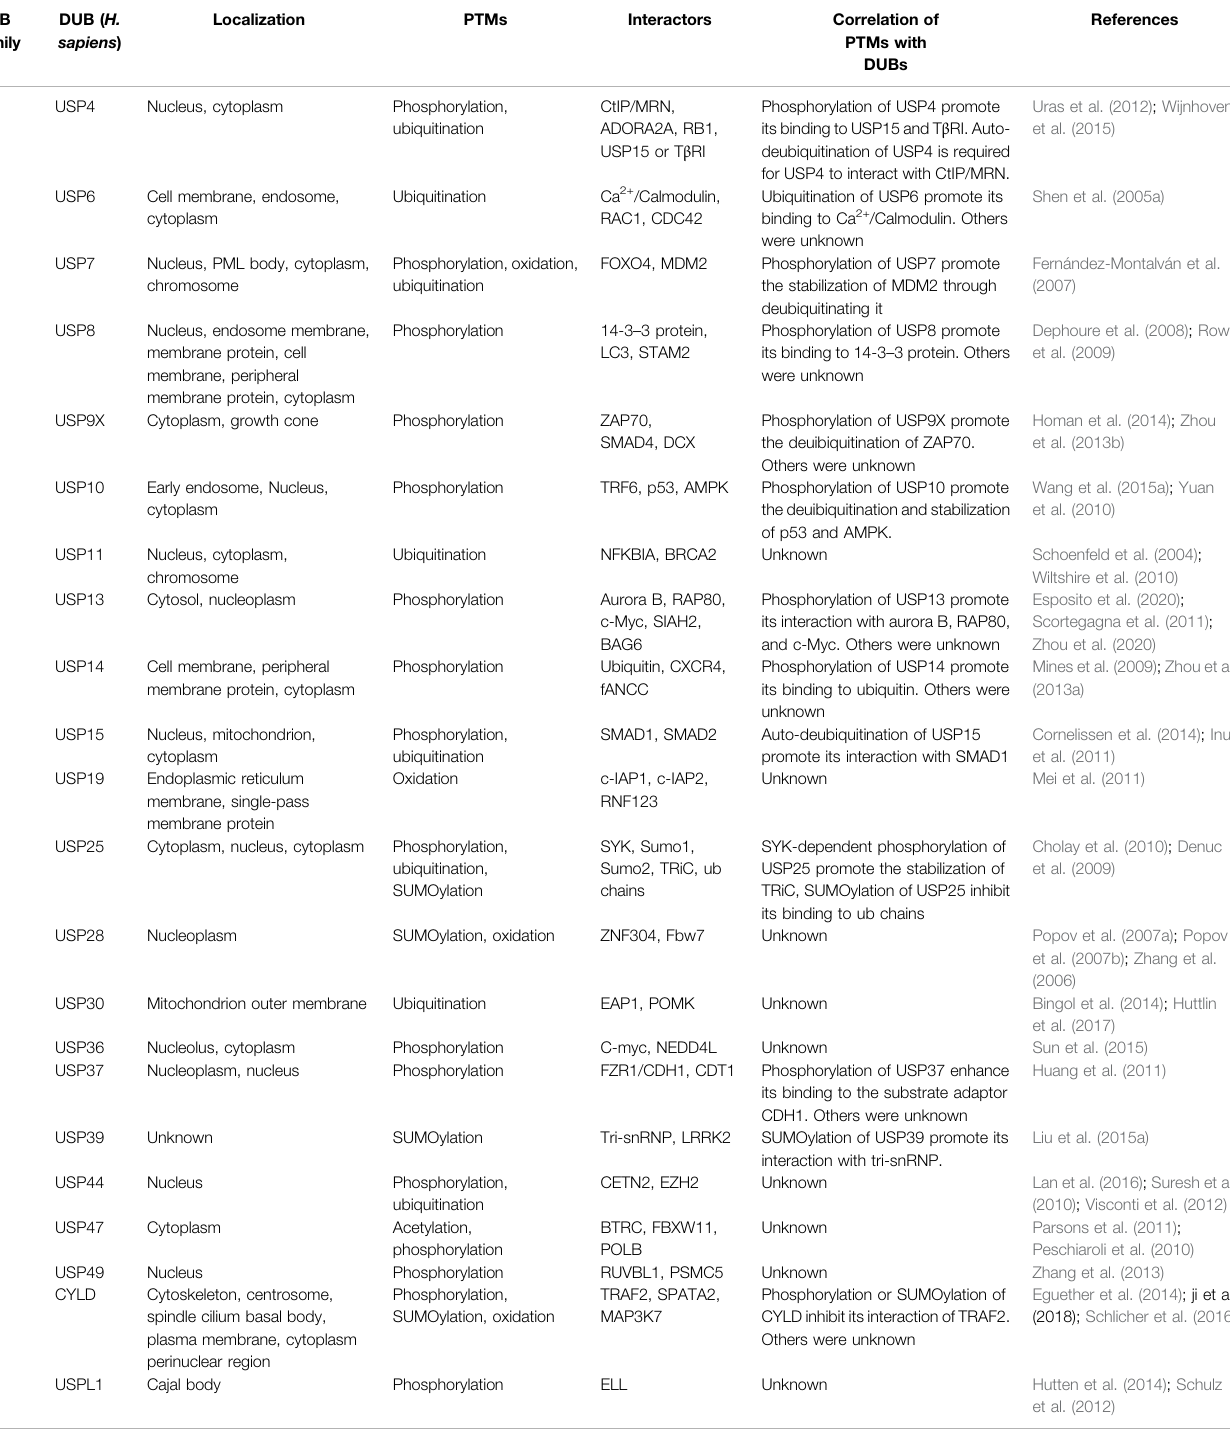
TABLE 1 | ( Continued ) Summary of DUBs localization, PTMs and interaction pro fi